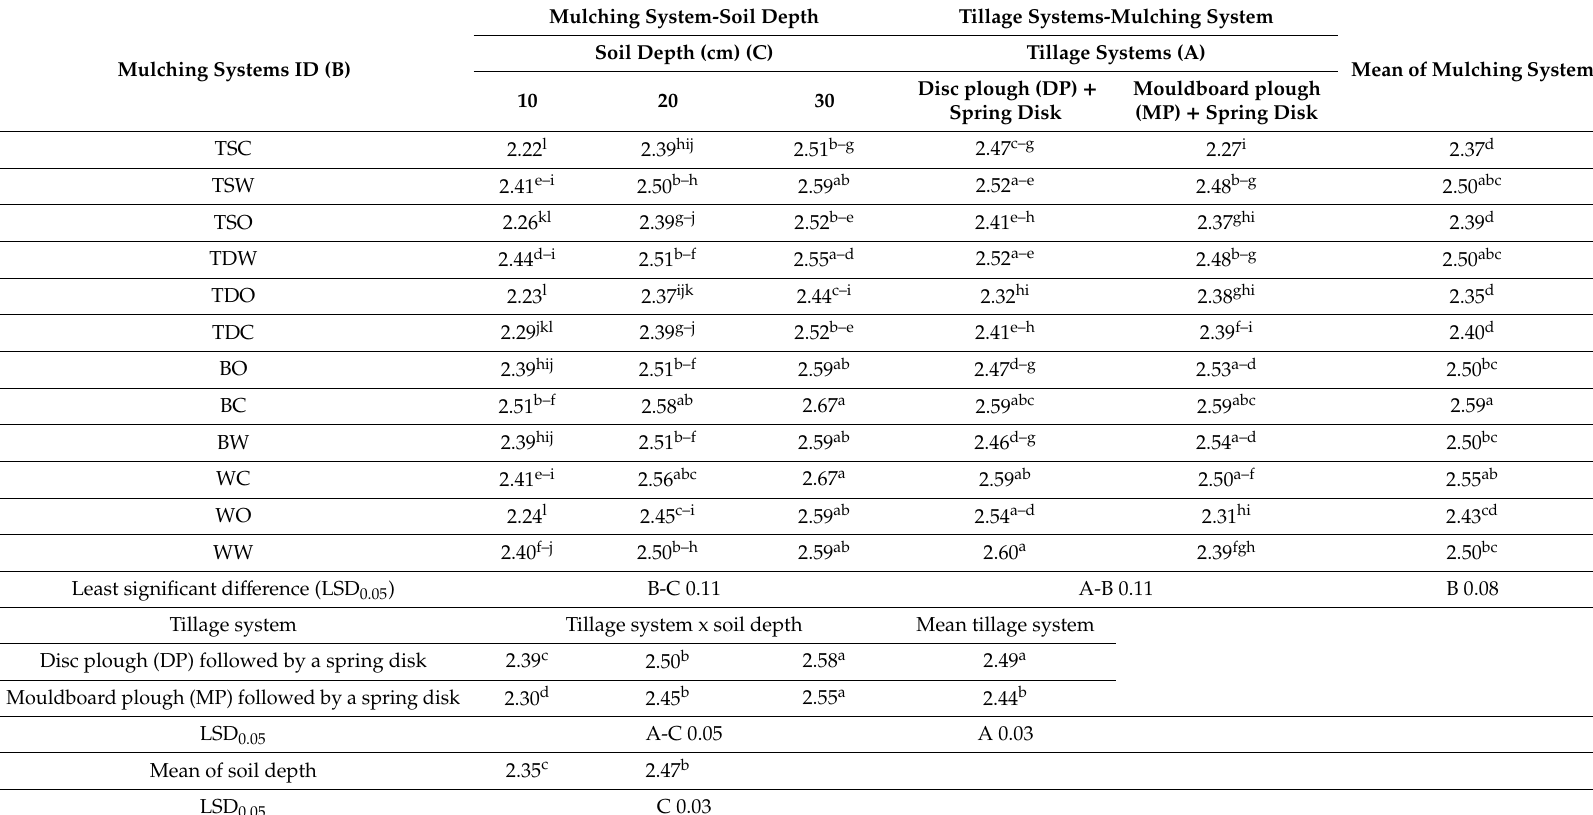
Table 4. Mean of soil dielectric constants ( ε ’) at various soil depths for the di ff erent soil